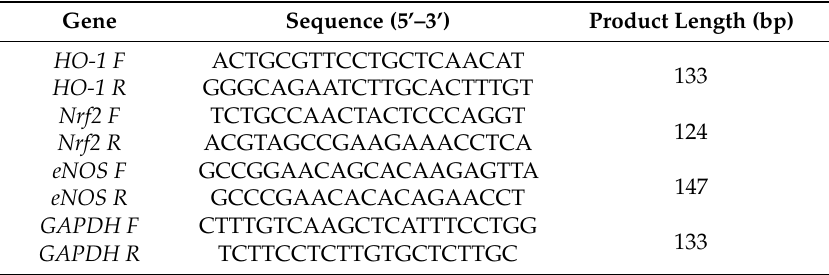
Table 1. Primer sequences used for qRT-PCR